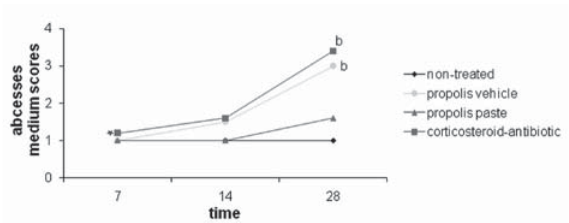
Figure 4- Progression of abscess medium scores of